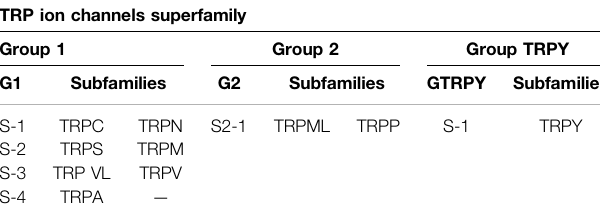
TABLE 1 | Transient receptor potential channels (TRP ion channels) groups and